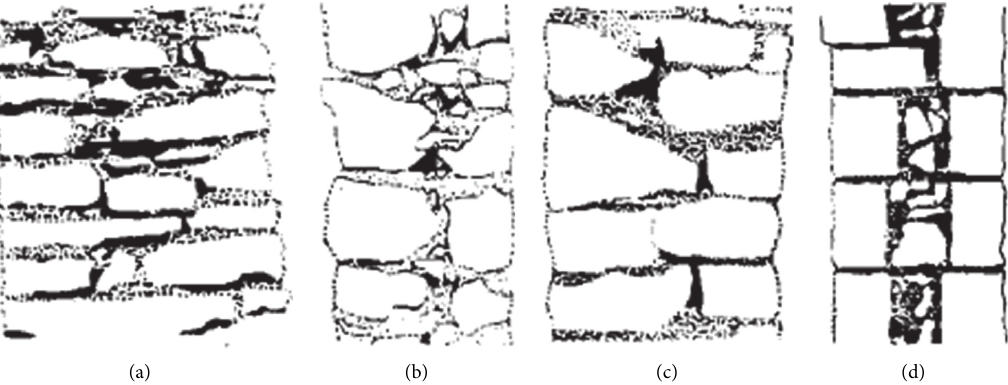
Figure 1: Stone Masonry classification by cross section: (a) single leaf or solid, (b) two leaves without connection, (c) two leaves with connection, and (d) three leaves (courtesy: